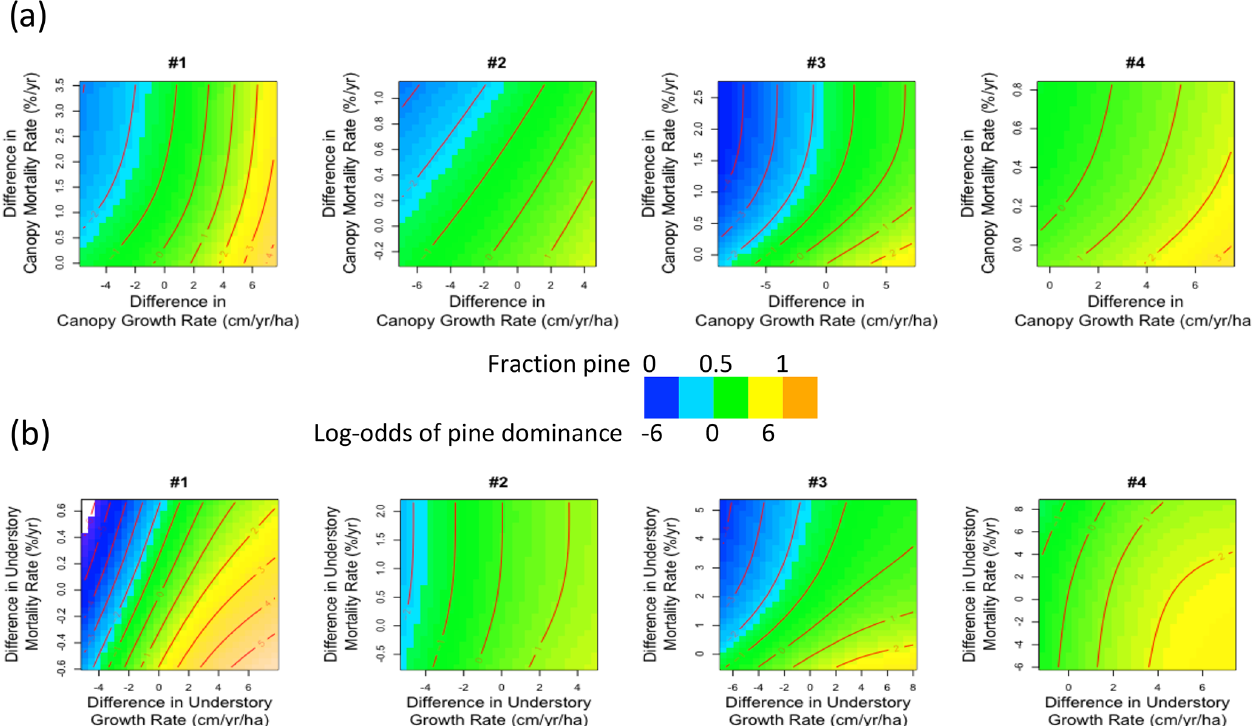
Figure 9. Effects of differences (pine minus cedar) in (a) canopy and (b) understory growth and mortality rates on the log-odds of pine dominance, or the fraction of pine basal area to the total basal area of pine and incense cedar, at the end of four FATES simulations started from bare ground and run with fire active over a regional domain in the Sierra Nevada mixed-conifer forest for 100